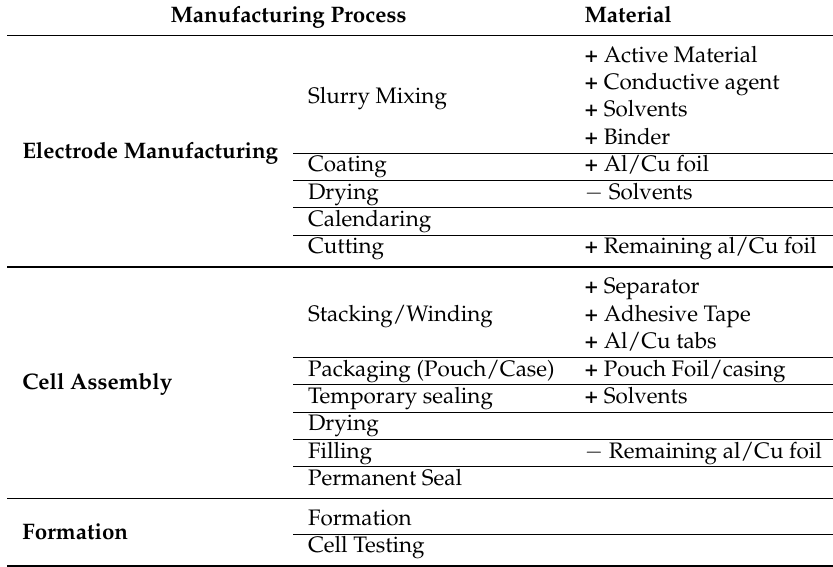
Table 6. Battery cell manufacturing process summary including material in- and